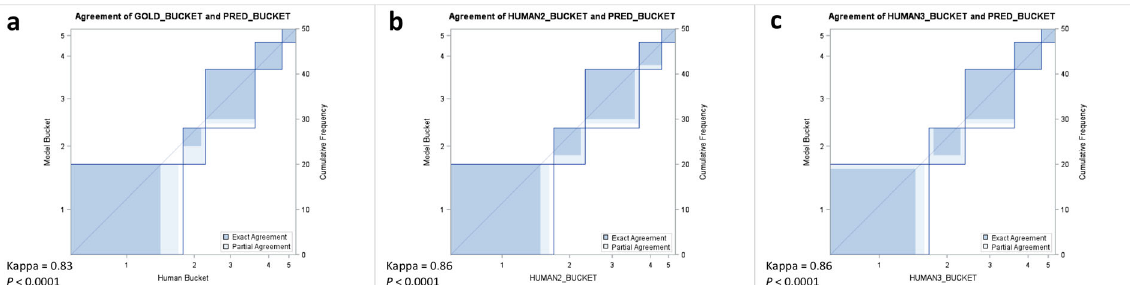
Fig. 4 Comparison of automated and manual scoring in a prospective cohort. Cohen ’ s Kappa statistic agreement plots comparing automated scoring to manual scoring by three different ( a – c ) technologists using gated coronary CT